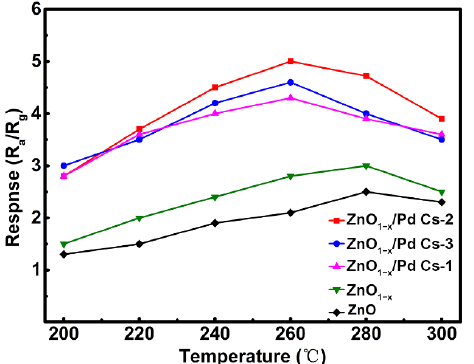
Figure 10. Response of all the sensors to CH 4 at different operating temperatures (to 50 ppm, from 200 to 300 °C), 40% RH. 200 to 300 ◦ C), 40% RH.